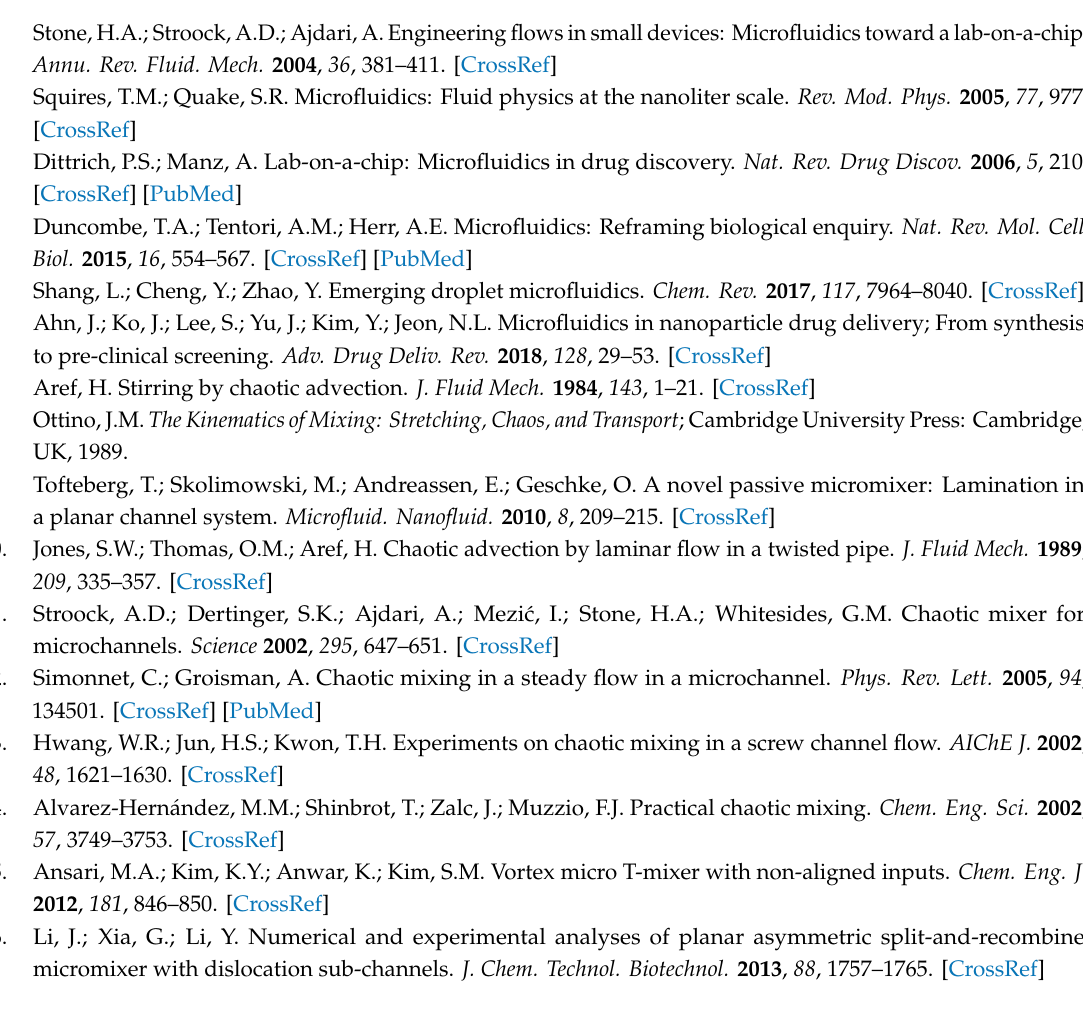
Figure S1: Fabrication process of the fluidic mixer. The template is fabricated using 3D printing. The mixed PDMS solution (base and curing agent, 10:1) is transferred into the template, which is followed by incubated at 45 ◦ C for 24 h. The cured PDMS is then sealed with glass slides through plasma etching. Figure S2: ( a ) Optical image and ( b ) schematic showing that the air-bubbles can be e ff ectively removed by integrating a degassing unit into the fluidic chip. (b) By collecting the mixed solution into an empty chamber, the gas and liquid can be quickly separated due to gravity. Figure S3: ( a , c ) Original optical images and ( b , d ) mono-color (red) images of the fluid channel. ( e ) Histogram of the selected area marked in Figure ( b ). ( f ) Histogram of the selected area marked in Figure ( d ). It is demonstrated that with air-bubbles as stirrers, the intensity distribution can become significantly narrower. Video S1: Movement of a droplet within a straight fluidic channel. Video S2: Chaotic advection caused by the movement of small droplets within the bulk solution. Video S3: Operation of a fluidic mixer chip integrated with a degassing unit. It is demonstrated that the air-bubbles are trapped in the large reservoir, and the “clear” mixed solution is collected